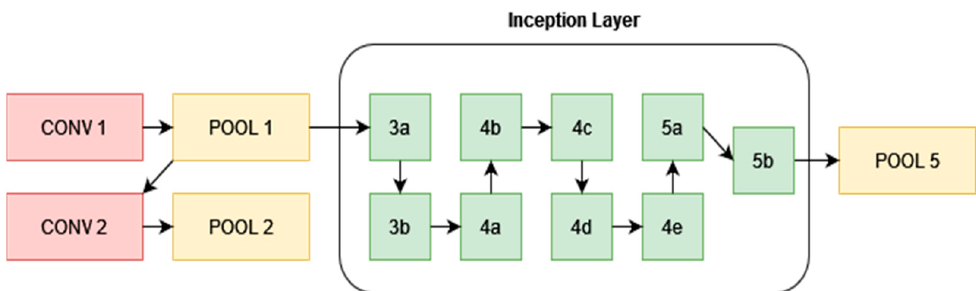
Figure 8. Simplified GoogleNet architecture.